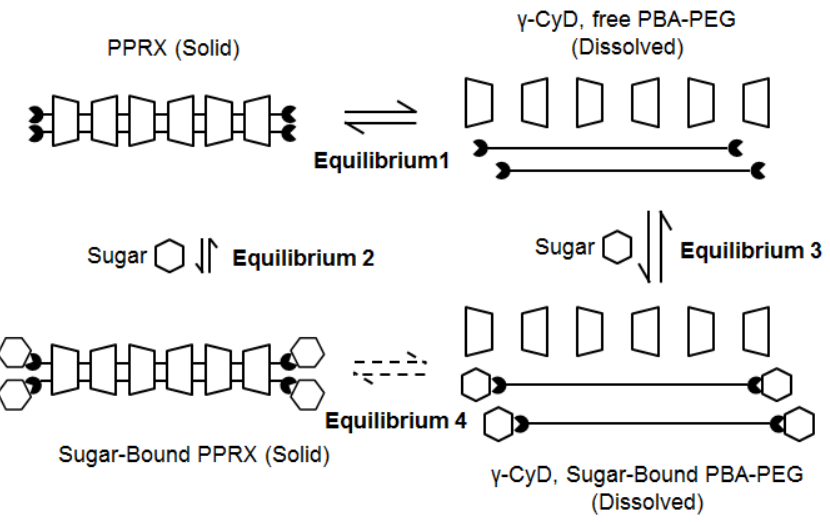
Figure 4. Proposed mechanism of sugar-induced disintegration of